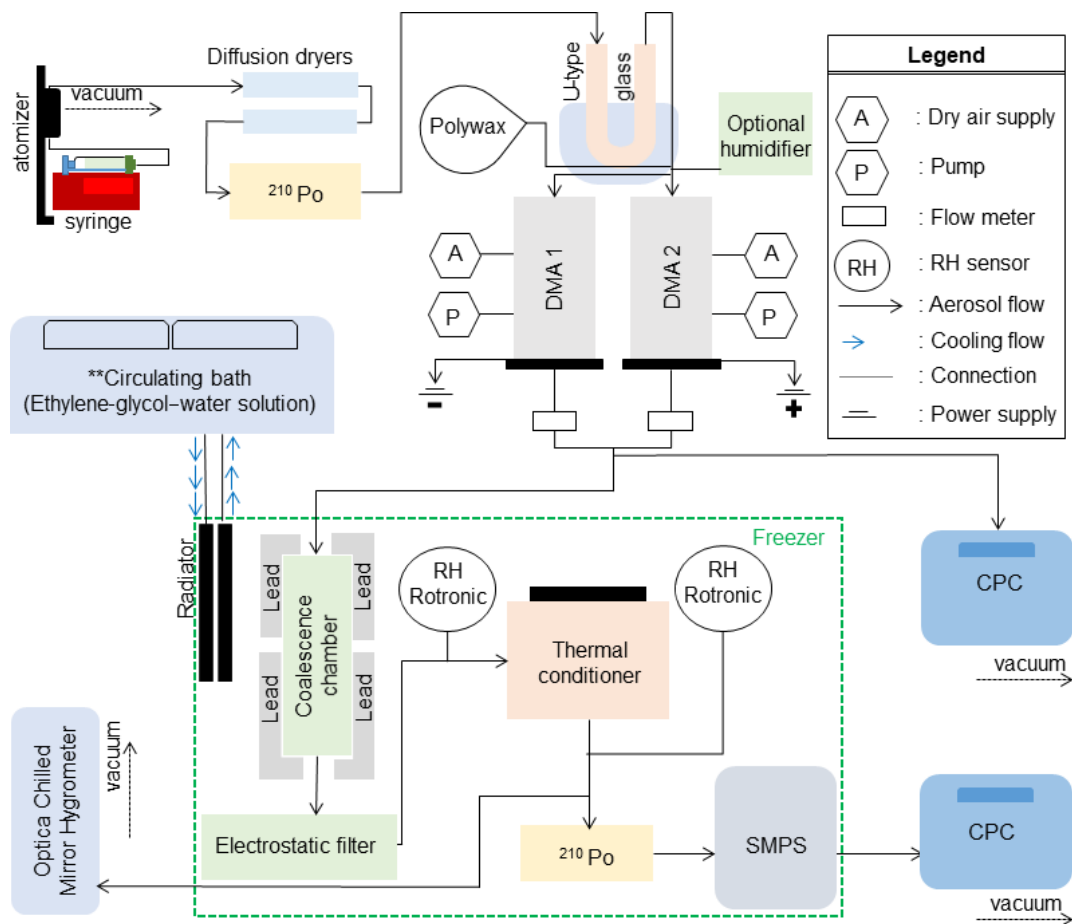
Figure 1. Schematic view of the experimental setup for sucrose–citric-acid experiments.